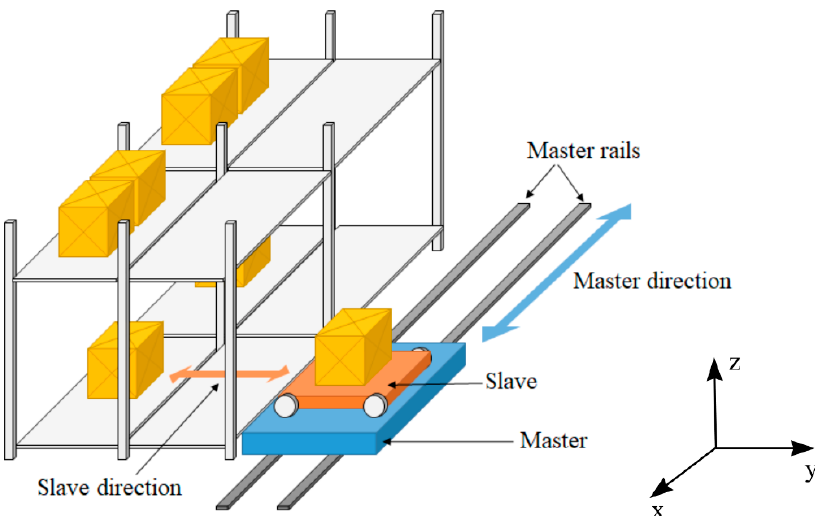
Figure 1. Basic structure of an automated warehouse (courtesy of [3]). The slave moves in y direction while the master is able to move in both x and z directions.